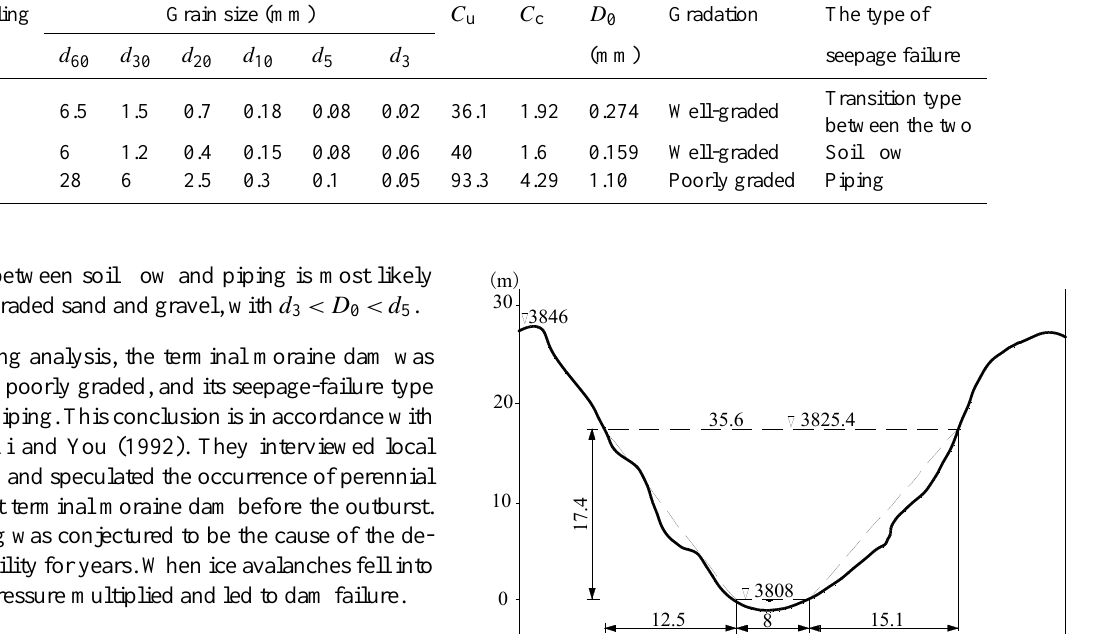
Figure 4. The cross-sectional profile of breach in the Guangxieco Lake (the number is in units of meters and the symbol represents